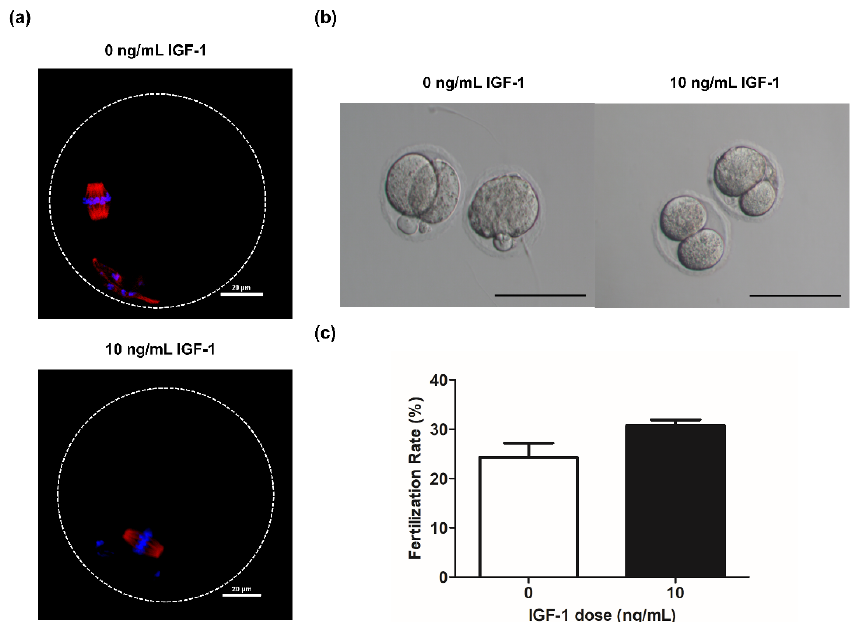
Figure 6. ( a ) Grown oocytes underwent germinal vesicle breakdown and progressed to metaphase II in group G0 and G10; ( b ) Embryo morphology at the two-cell stage in group G0 and G10. Scale bar: 100 µm; ( c ) The fertilization rate in group G0 ( n = 37) and G10 ( n = 39).